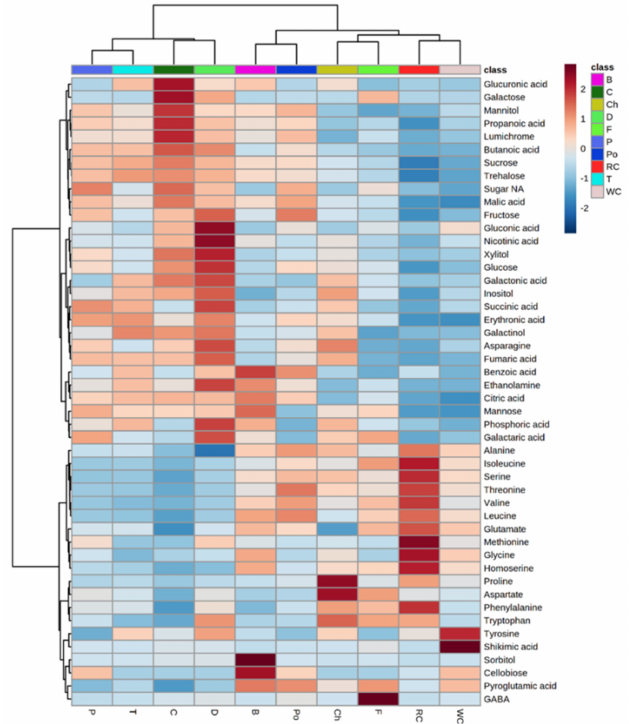
Figure 3. Heat-map analysis of the 58 primary metabolites detected by GC-MS. The data represent four replicates for each parasite that developed on each host plant. A total of 10 hosts were examined. Host plants are designated as Broccoli (B), Red cabbage (Rc), White cabbage (Wc), Potato (Po), Pepper (P), Tomato (T), Carrot (C), Dill plant (D), Fennel bulbs (F) and Chickpea